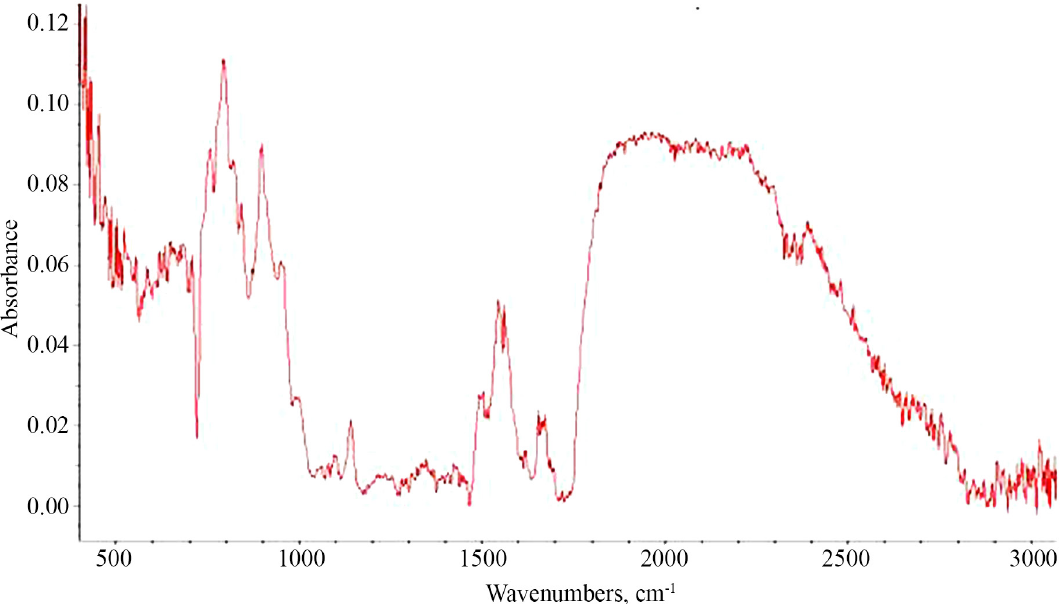
Fig. 2. IR spectrum of a macromolecular compound obtained by extraction with hexane of a substance obtained by a barothermal